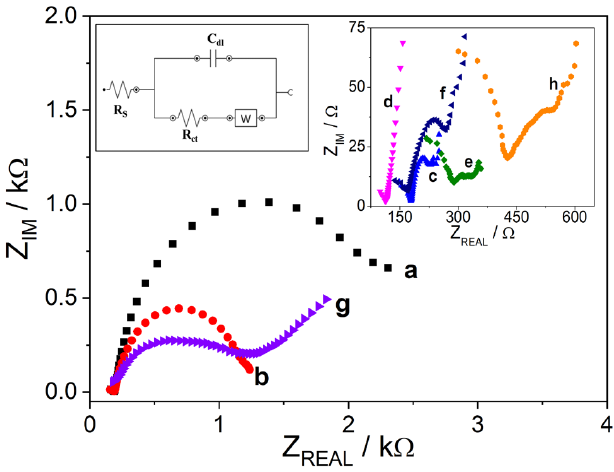
Figure 9. Nyquist plots registered for: (a) SPE, (b) MWCNT/SPE, (c) MWCNT-CS/SPE, (d) MWCNT- AgNP-CS/SPE, (e) MWCNT-SG/SPE, (f) MWCNT-AgNP-SG/SPE, (g) MWCNT-1,8-DAN/SPE, and (h) MWCNT-AgNP-1,8-DAN/SPE. Inset: Randles equivalent circuit (frequency range: 1 MHz–10 Hz, AC amplitude: 10 mV, OCP).